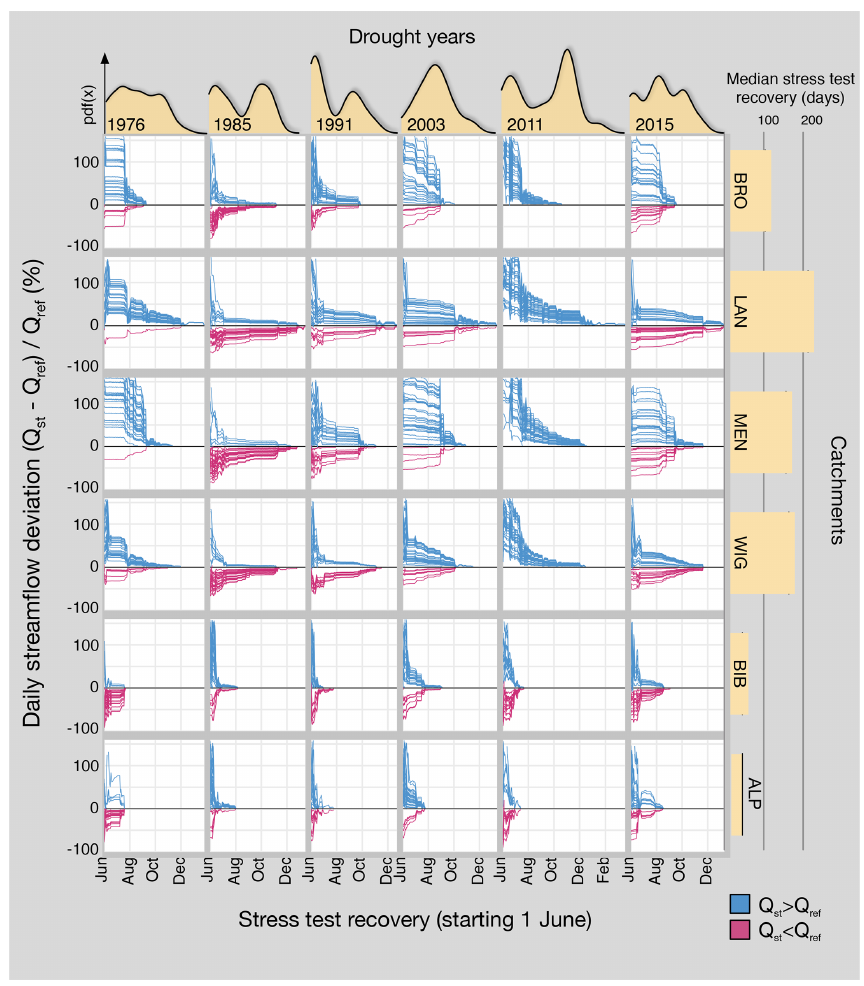
Figure 2. Evaluation of recovery time after ST NAT for different drought years (columns) and catchments (rows) where Q st is streamflow from stress test simulation and Q ref is streamflow from reference simulation. Density curves (top) and barplots with median values (right) show the distributions of recovery times across drought years or catchments. y -axis is truncated at + 150% to improve